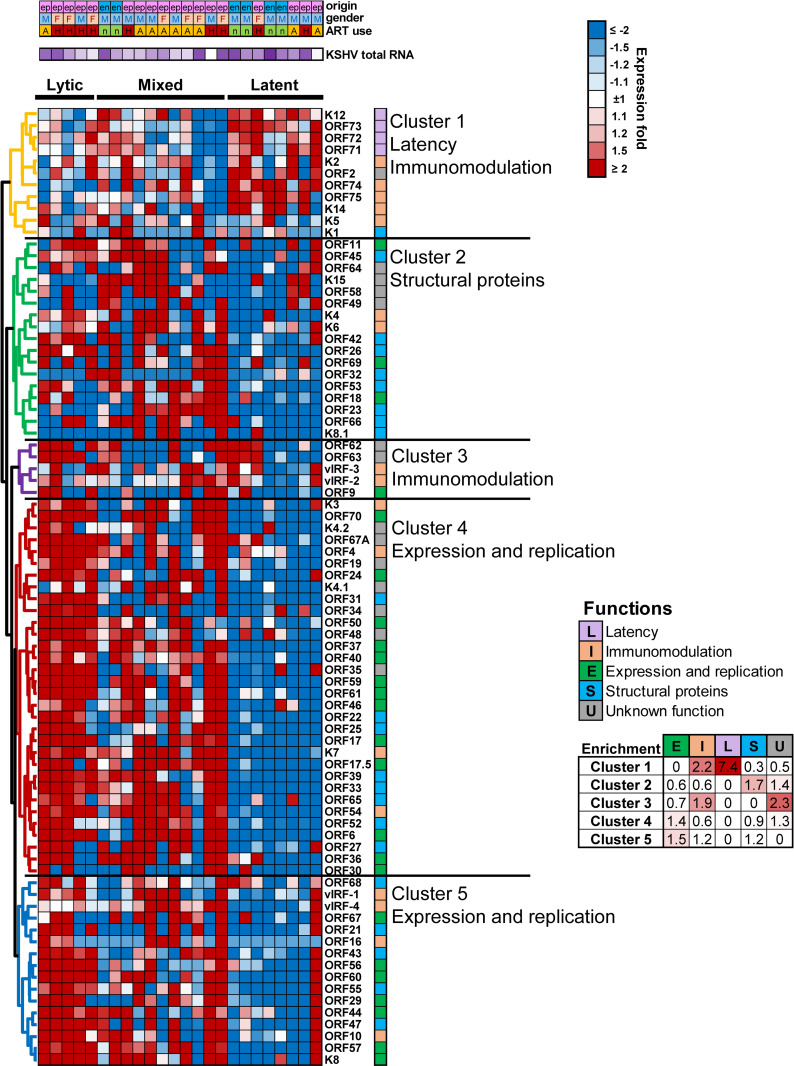
Hierarchical clustering of KSHV genes and samples.ART–Antiretroviral therapy, KSHV–Kaposi’s sarcoma (KS)-associated herpesvirus, en–endemic KS, ep–epidemic KS, M–Male, F–Female, A–ART treated, H–ART naïve, n–HIV-1 negative.